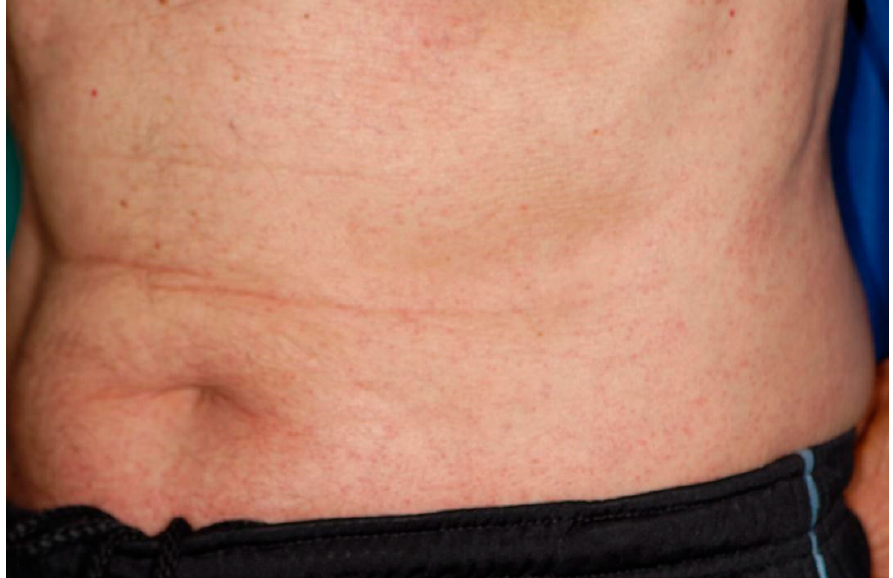
Figure 7. Skin rash erythema (Patient no. 7, Table 3).